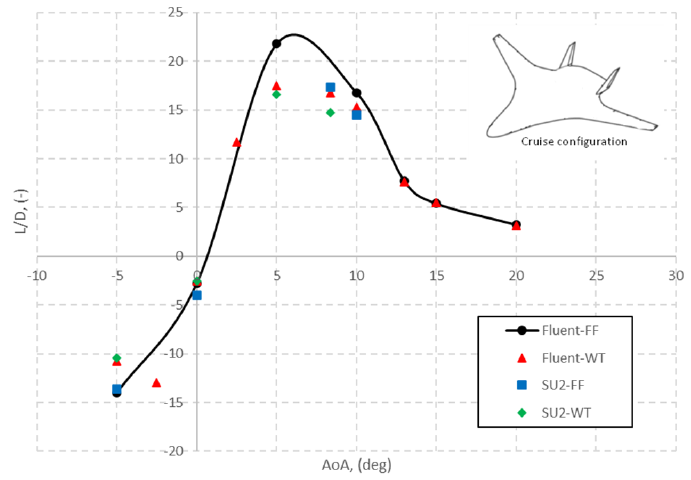
Figure 23. Lift-to-drag ratio versus AoA, effect of Reynolds